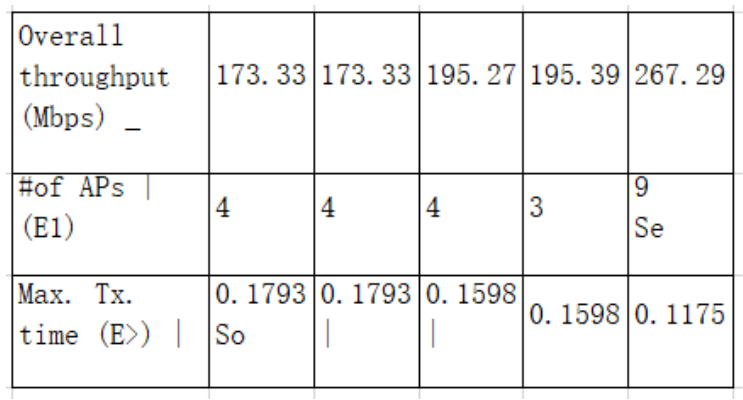
Figure 24. Excel output for scanned table image 4 by our algorithm.